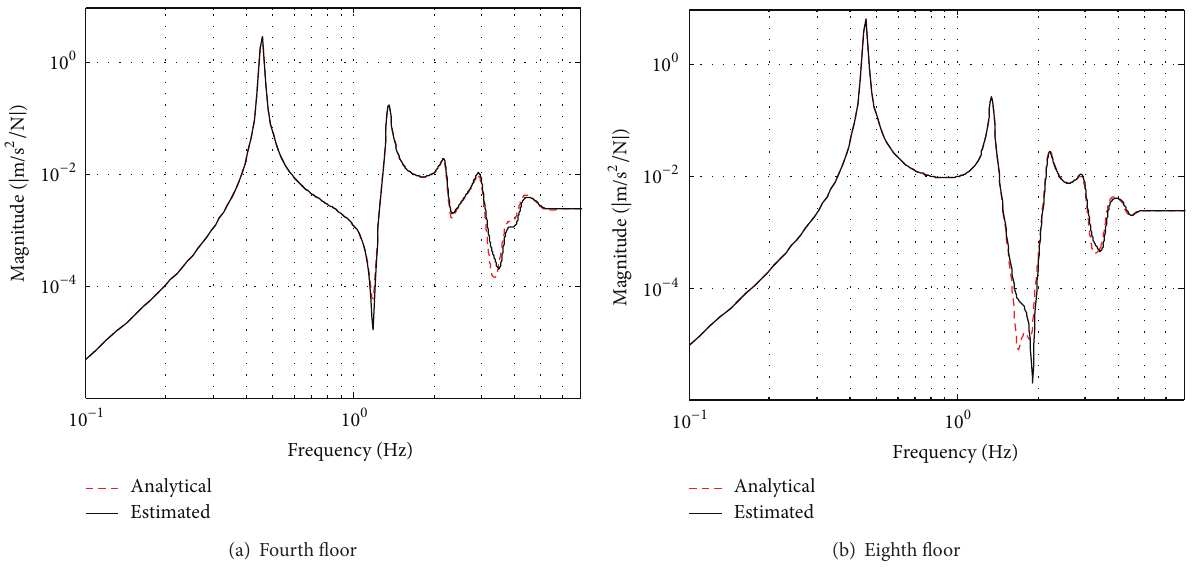
Figure 5: Comparison of the magnitude of frequency response functions (accelerances) for the fourth and eighth floor accelerations.